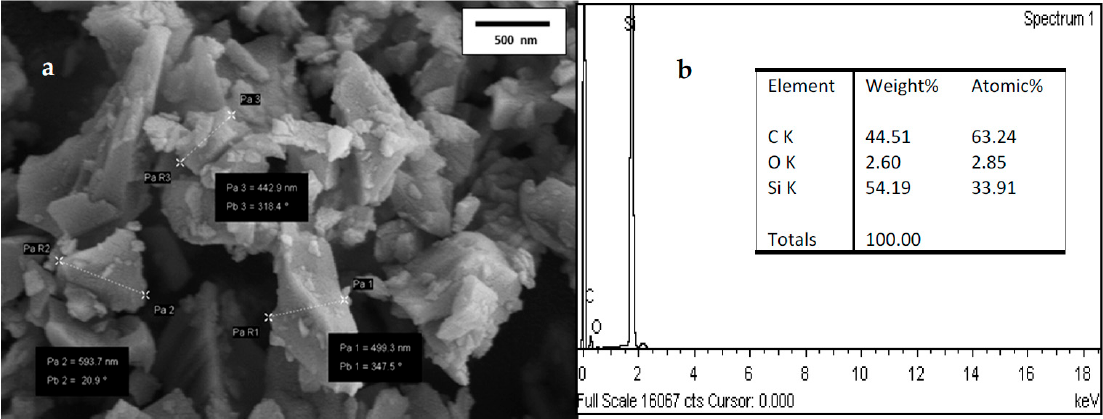
Figure 2. ( a ) FESEM of 3C-SiC nanoparticles. ( b ) EDX of 3C-SiC nanoparticles.